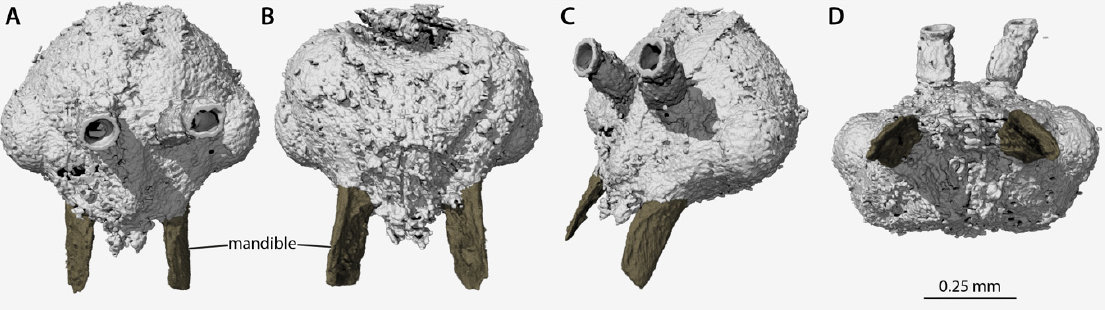
Figure 4. Volume renders of the segmented data from the head of † Desyopone hereon gen. et sp. nov., holotype MAIG 6016, showing the highly unusual mandibles. ( A ) full-face view; ( B ) ventral view; ( C ) dorsolateral anterior oblique view; ( D ) oral view. Scale bar approximate due to slightly unequal scaling of images for depiction.